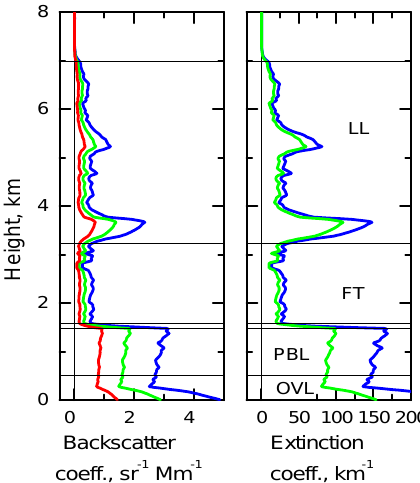
Figure 10. Input data of the algorithm inter-comparison exercise. Profiles of particle backscatter (left) and extinction coefficients (right). The colors indicate the wavelengths: Blue corresponds to 355nm, green to 532nm, and red to 1064nm. Horizontal black lines indicate the layers PBL, FT, and LL where the layer mean deviations of Fig. 11 to 15 have been derived. The layer of incom- plete overlap (OVL) has been excluded from